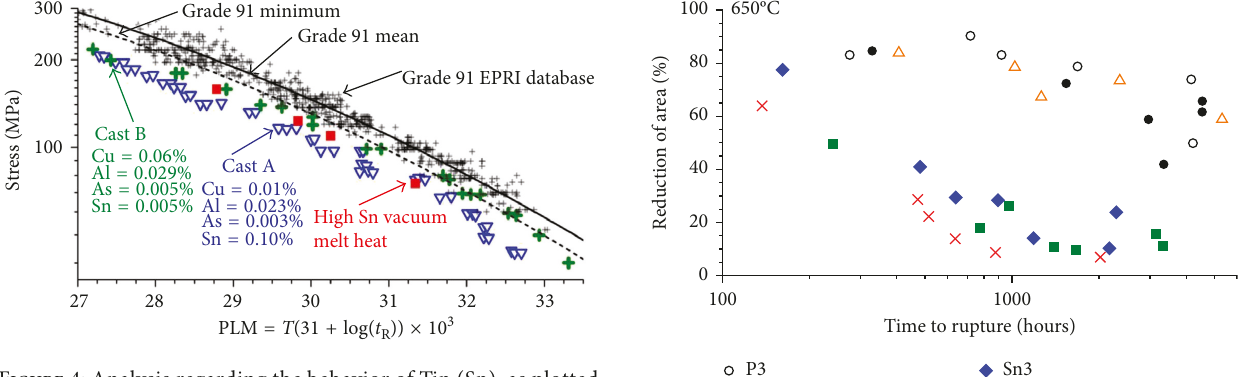
Figure 4: Analysis regarding the behavior of Tin (Sn), as plotted against the EPRI database of Grade 91 base metal using a Larson Miller parameter ( C 31), adapted from [27]. Note the reduction (cid:31) in strength for all casts with Sn. Even at the lowest value of 0.005 Figure 5: Analysis of Grade 91 behavior for experimental heats weight percent, the behavior is at the minimum (mean-20%) doped with P, S, Cu, Sn, and Sb and as compared to a control heat line. This reduction in strength may also be partially attributed (P1) with low levels of tramp elements. Adapted from [27]. Note to the presence of relatively high levels of Al in all examined the marked decrease in reduction of area for heats doped in Cu, Sn, heats. and Sb and the more gradual drop in behavior with time for heats doped with S and